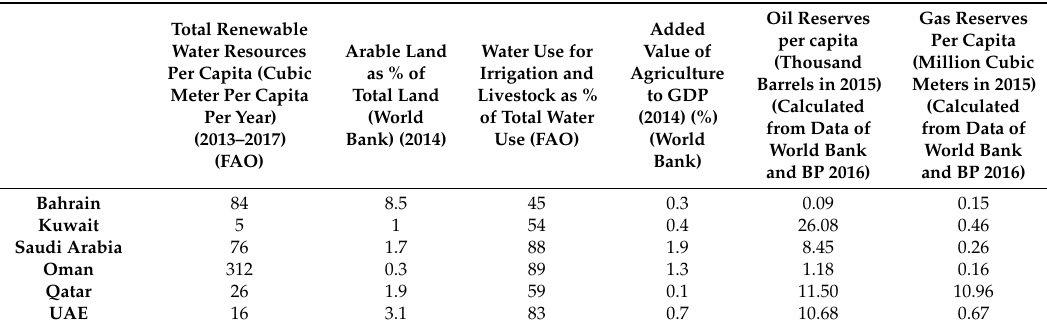
Table 1. Key data on water, energy and resources in the GCC countries (data from Food and Agriculture Organization (FAO) AQUASTAT, World Bank indicators and British Petroleum